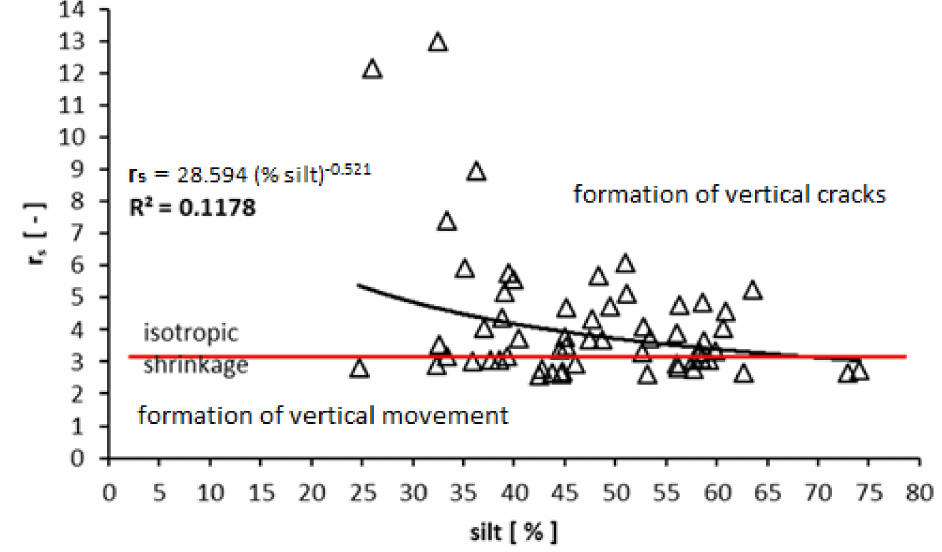
Figure 4. Relationship between the geometric factor, r s , and the grain content of particles sized between 0.002–0.05 mm, which represents the percentage of silt particles in the soil